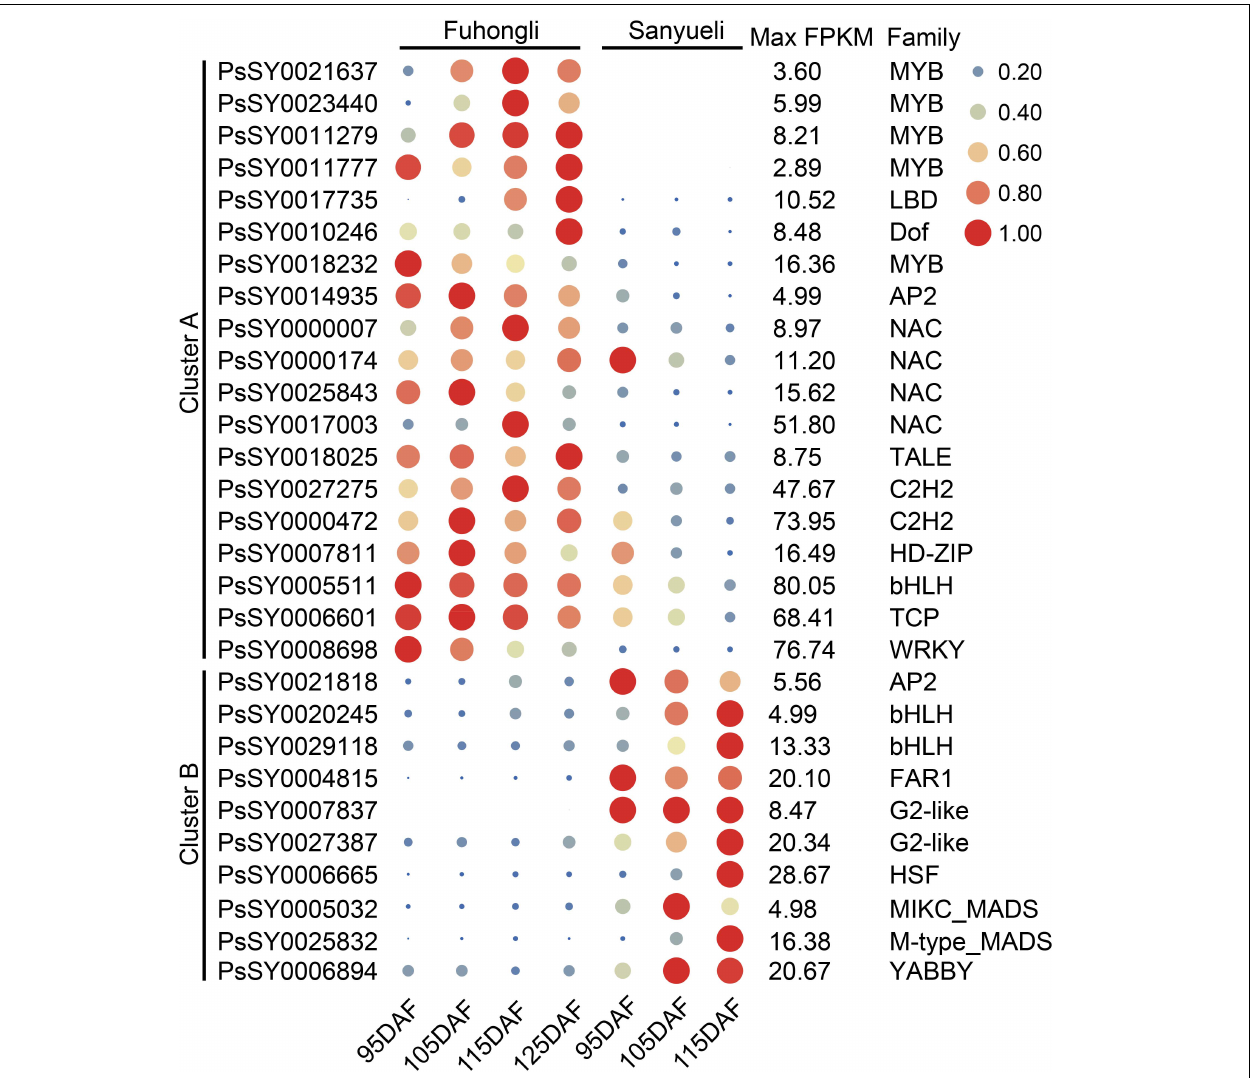
FIGURE 5 | qRT-PCR validation of DEGs in flesh of ‘Sanyueli’ and ‘Fuhongli’ during fruit ripening. Actin was used as the reference gene. The error bars represent the standard error of three biological replicates. The left y-axis shows the relative gene expression levels obtained by qRT-PCR (solid lines). The right y-axis indicates the corresponding results of RNA-seq (dashed